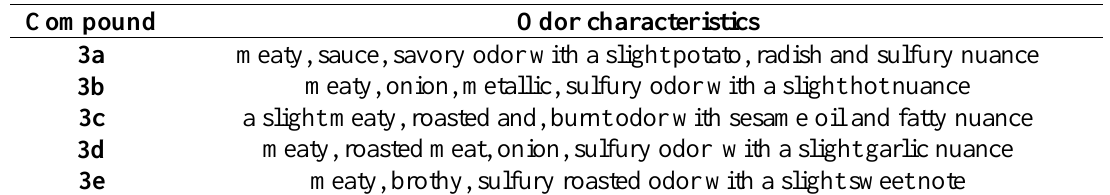
Table 2. The results of odor